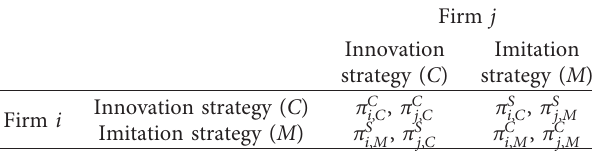
Table 1: The payoff matrix of the basic evolutionary game